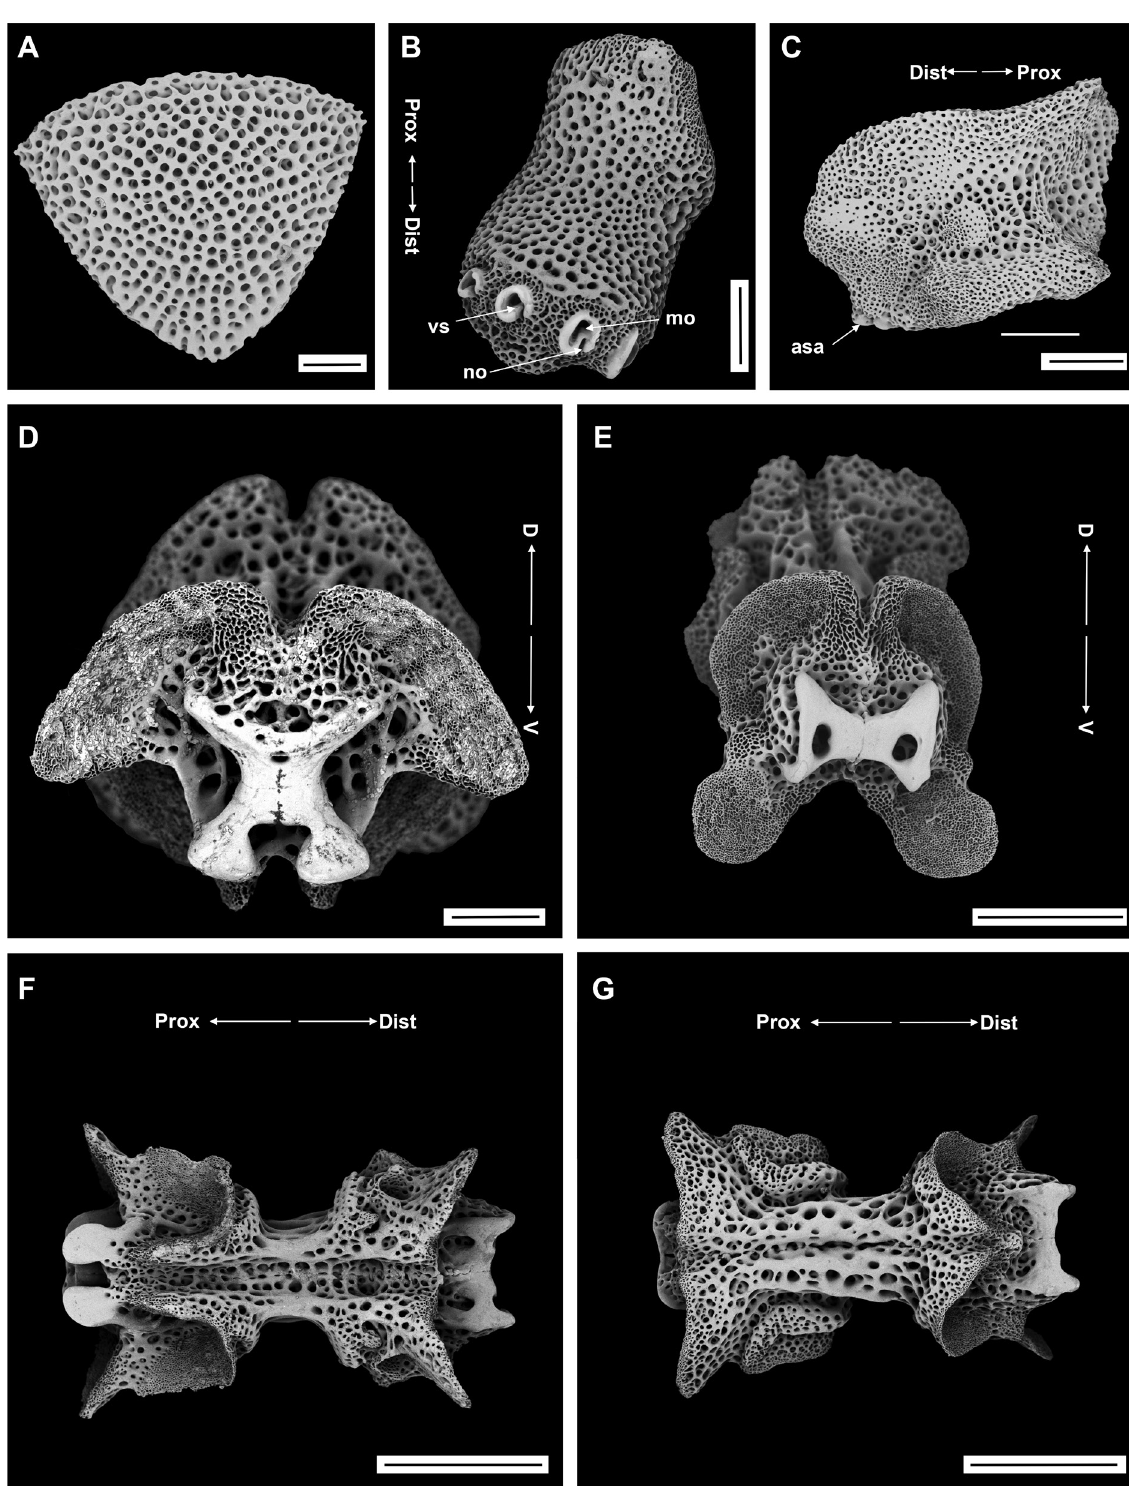
Fig. 24. Ophiurothamnus clausa (Lyman, 1878), SEM (IDSSE EEB-SW0023). A . Dorsal arm plate. B–C . Lateral arm plate. B . External view. C . Internal view. D–G . Vertebrae. D . Proximal view. E . Distal view. F . Ventral view. G . Dorsal view. Abbreviations: asa = arm spine articulation; D = dorsal; Dist = distal; mo = muscle opening; no = nerve opening; Prox = proximal; V = ventral; vs = volute- shaped. Scale bars: A, D = 100 µm; B, F–G = 300 µm; C, E = 200